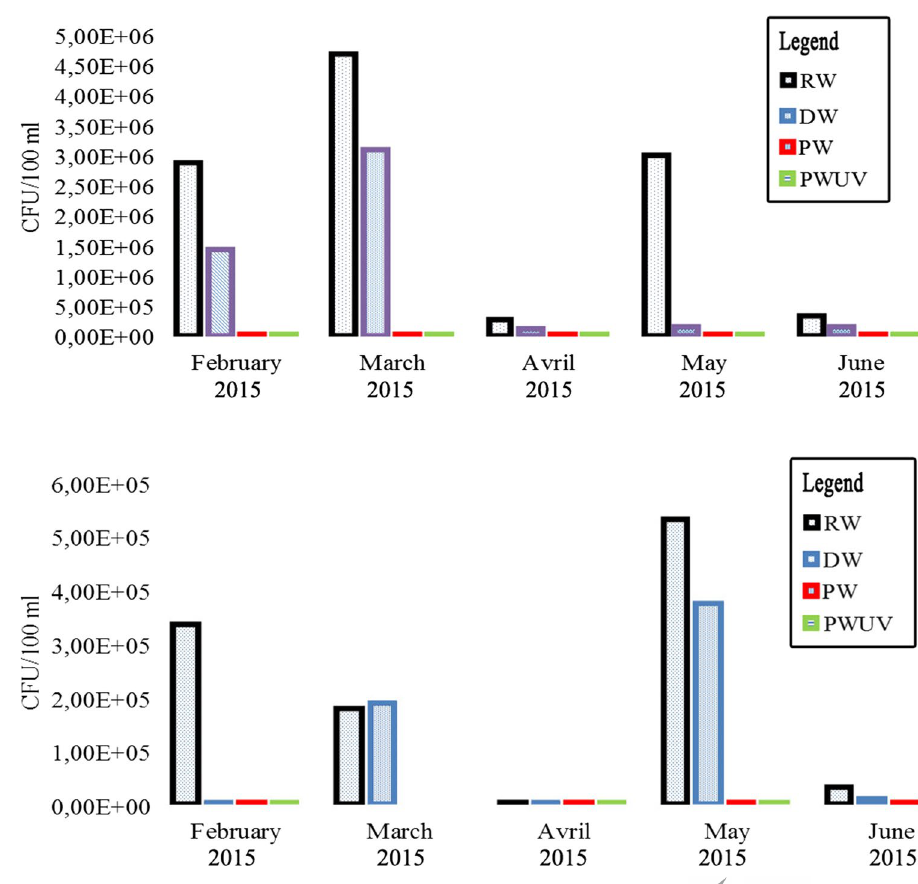
Fig. 2 Fecal coliforms levels in different types of wastewaters in Mzar treatment plant